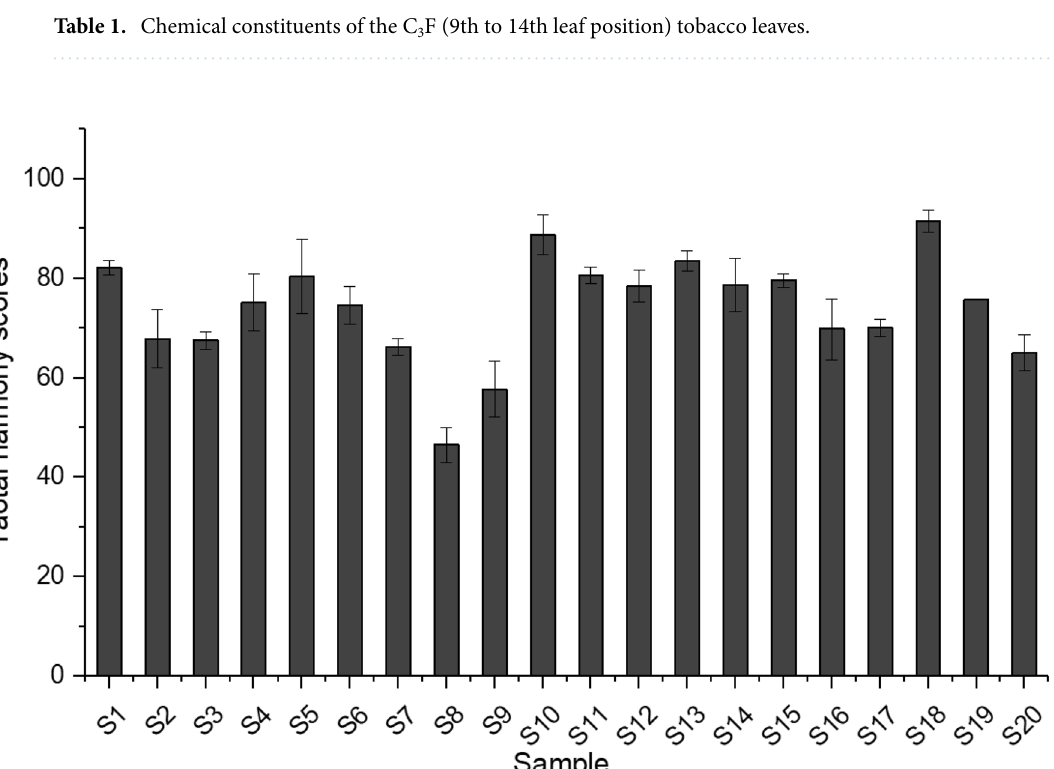
Fig. 2). Moreover, a strong and positive correlation between soil nitrate and plant nicotine level was observed (r = 0.451, p < 0.05), but tobacco nicotine had no significant correlation with soil ammonia ( p > 0.05, Fig. 2). A significant relationship of plant chloride level and soil organic matter content depicted the r = 0.569 and p < 0.05 values and are presented in Fig. 2. It was worthy to note that total nitrogen, sugars, and starch levels of tobacco had no significant association with soil properties ( p > 0.05, Fig. 2).